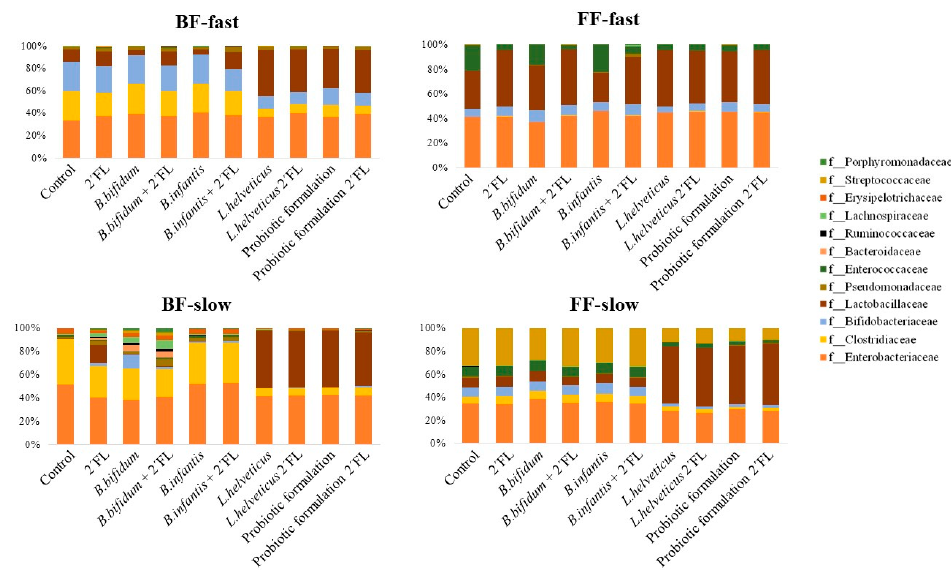
Figure 2. Relative abundance of bacteria at the family level at 24 h of incubation in fecal cultures with the different probiotics and the probiotic formulation added with and without 2 ′ FL for each fecal culture classification group, ranked according to the feeding type of donors and the intrinsic capacity of the basal microbiota to degrade 2 ′ FL [7].